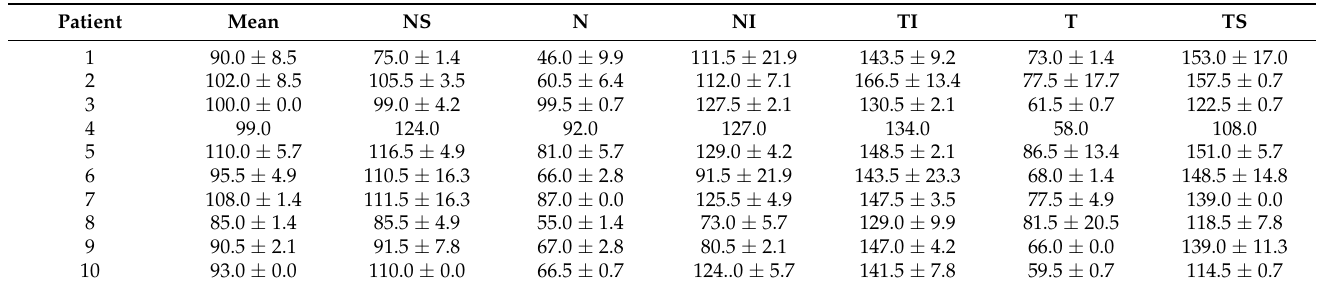
Table 2. The thickness of the retinal nerve fibre layer in various parts of the optic disc for 10 patients is listed out.